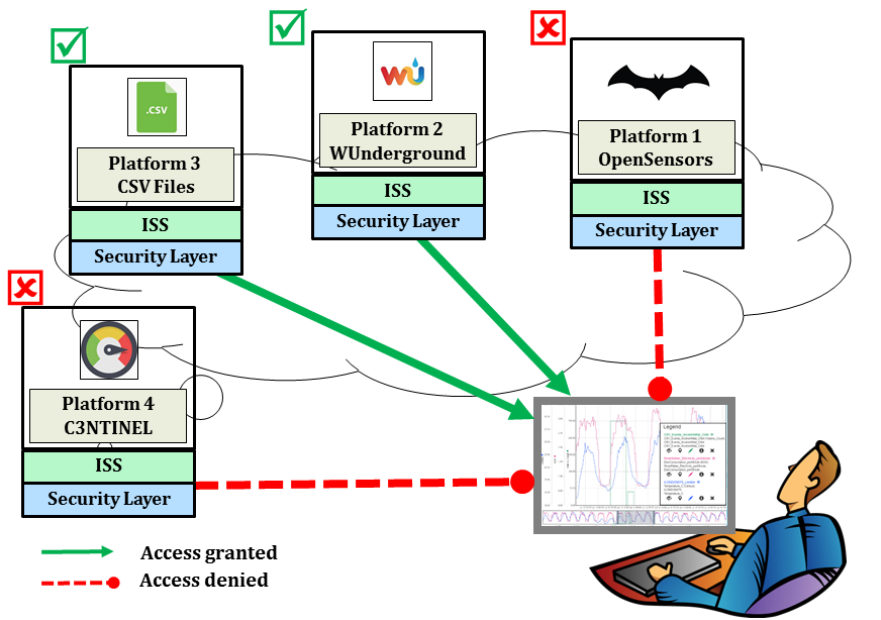
Figure 8. Configuration of the InterSensor Service with an additional security layer by the respective stakeholder. It allows ensuring secure access to the platform with proper access